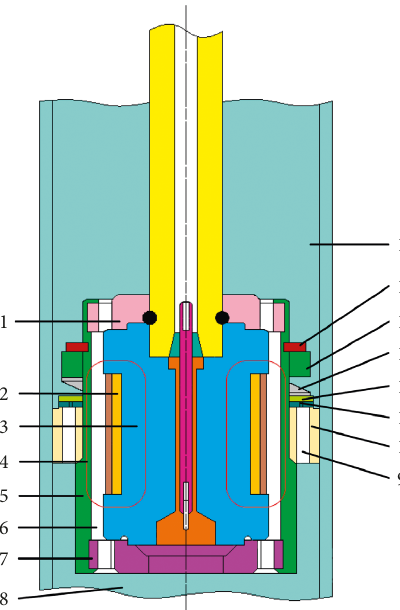
Figure 25: MR piston assembly with bypass valving: 1, first end plate; 2, coil; 3, core; 4, magnetic flux; 5, shell; 6, first flow pas- sageway; 7, second end plate; 8, compression chamber; 9, openings; 10, valve seat; 11, orifice disc; 12, valve plate; 13, spring; 14, spacer; 15, retaining ring; 16, rebound chamber [82].